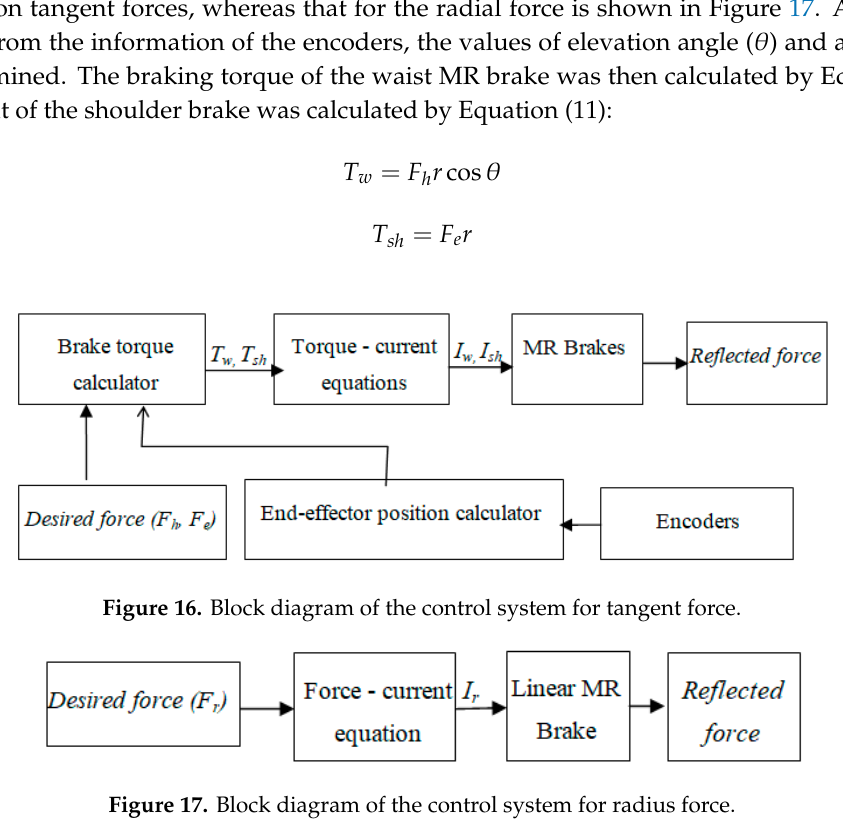
Figure 17. Block diagram of the control system for radius force.